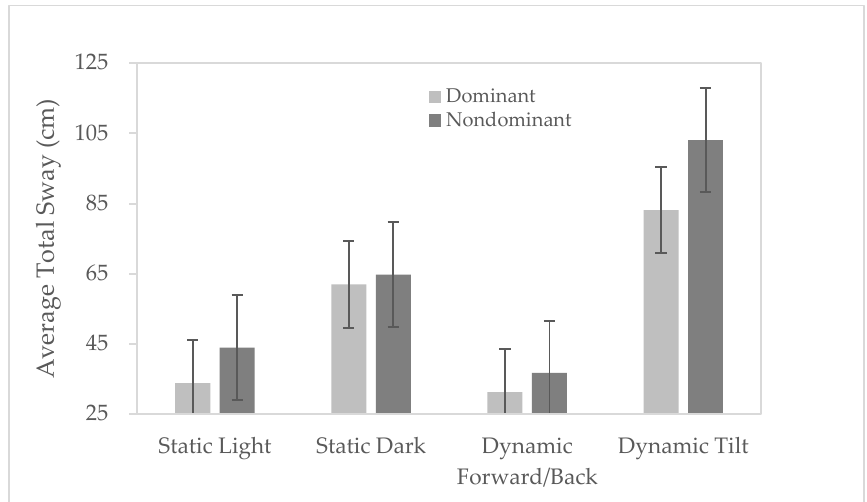
Figure 4. A graph showing the differences in mean total sway for the four different visual field conditions and for the dominant (light grey) and non-dominant (dark grey) stances. The error bars represent the standard deviations for the two different stance conditions.